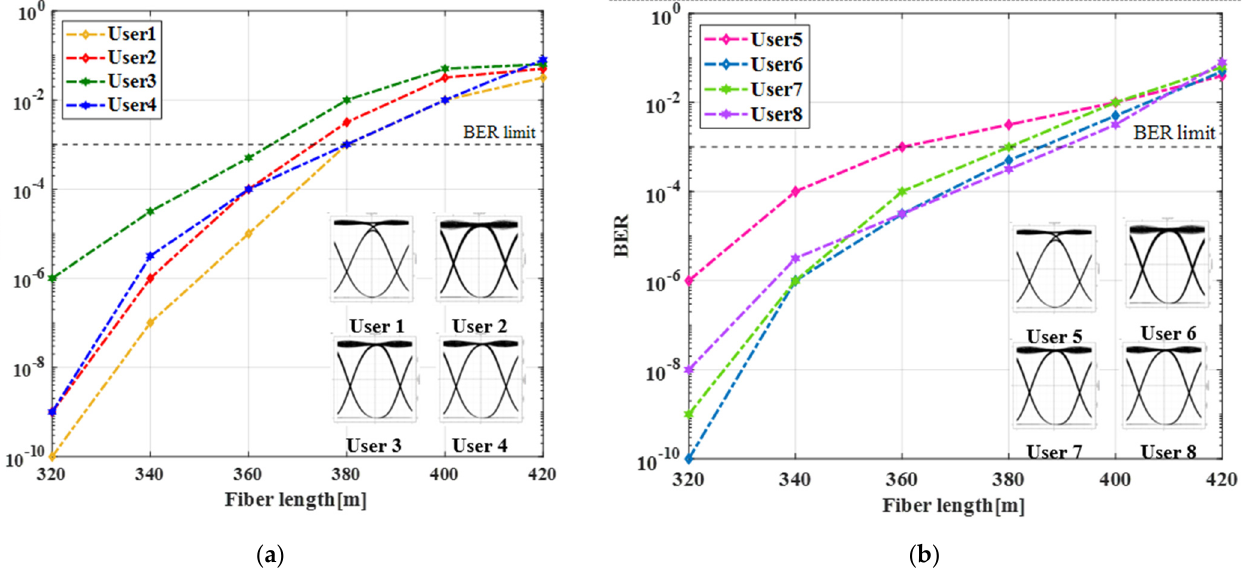
Figure 3. Measured BER at fixed FSO link of 100 m under clear air conditions. ( a ) Users 1 to 4 operating on Donut mode 0 and with corresponding eye patterns at 320 m fiber length, ( b ) users 5 to 8 operating on Donut mode 1 with corresponding eye patterns at 320 m fiber length.